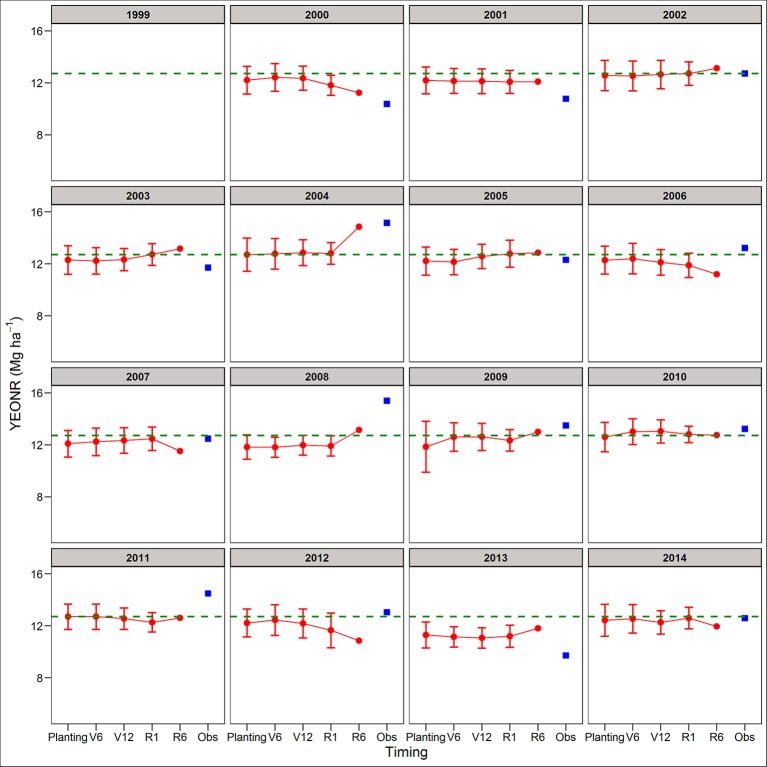
Predicted and observed yield at the economic optimum N rate (YEONR) for soybean-corn. The connected red dots indicate APSIM model predictions at planting time, V6 (6th leaf), V12 (12th leaf), and R1 (silking) stages using actual and historical weather data (vertical bars indicate standard deviation, n = 35). At maturity (R6), the weather is known so there is no uncertainty in yield prediction. Blue squares represent the observed YEONR. The green dashed line represents the mean YEONR for the study period at this site.